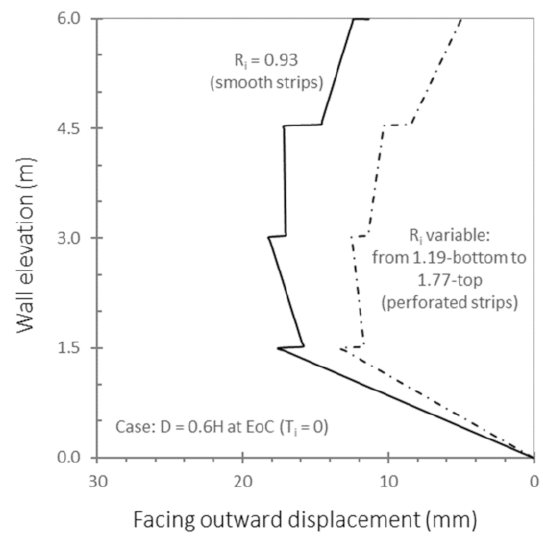
Figure 22. Facing displacements computed at the end of construction (EoC) using different polymeric–soil interface strengths and stiffness ( R i -factor) for the D i = 0.6 H case with no pre-tensioning. (Modified from [16]).